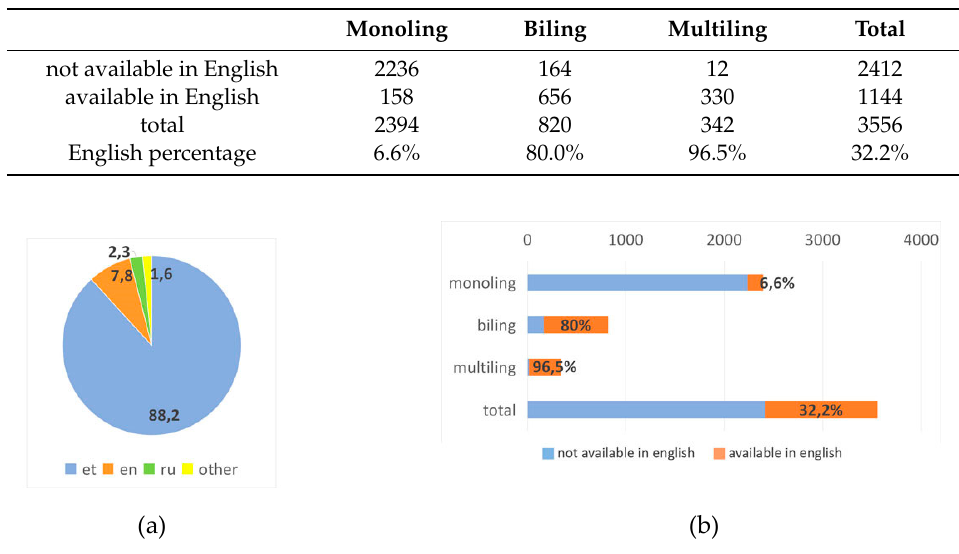
Table A17. Primary languages (fi).